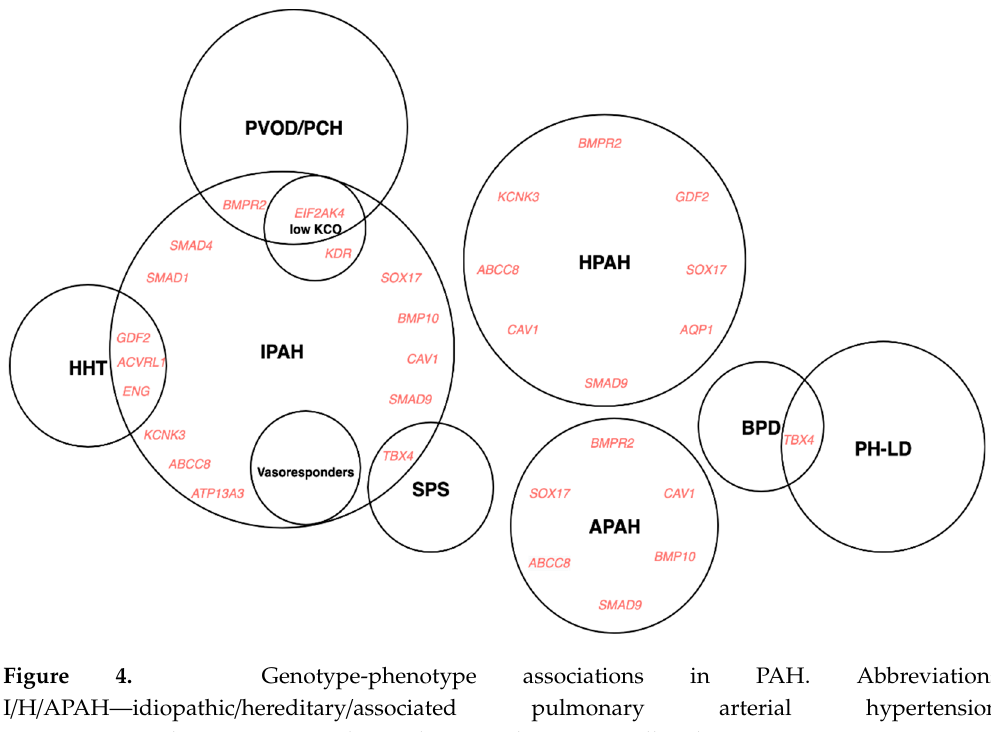
Figure 4. Genotype-phenotype associations in PAH. Abbreviations: I/H/APAH—idiopathic/hereditary/associated pulmonary arterial hypertension; PVOD/PCH—pulmonary veno-occlusive disease/pulmonary capillary haemangiomatosis; SPS—small patella syndrome; BPD—bronchopulmonary dysplasia; HHT—hereditary hemorrhagic telangiectasia.